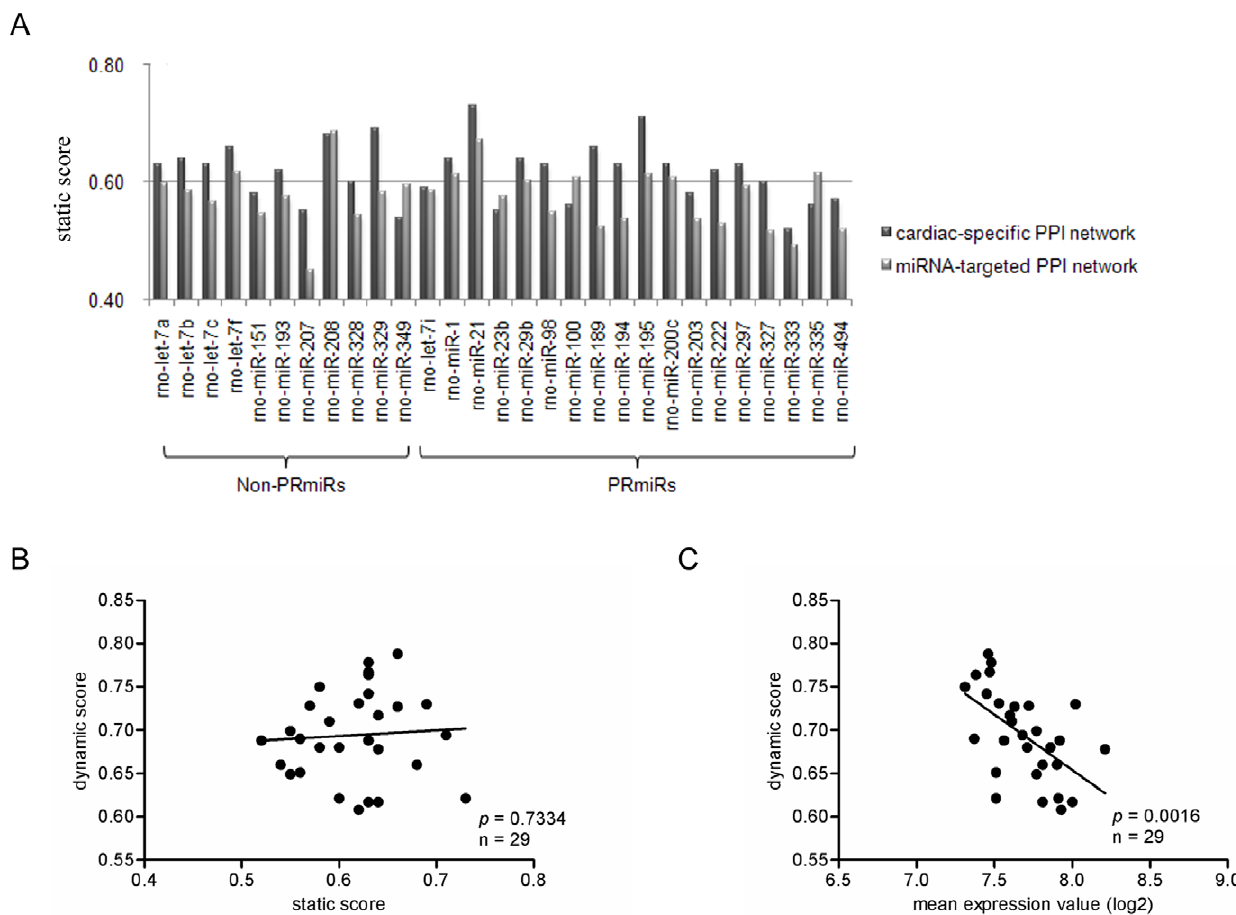
Figure 2. Results of static and dynamic network analyses. A. Static scores of the 29 dysregulated miRNAs in myocardial infarction. B. Correlation between static score and dynamic score. C. Correlation between average target gene abundance (log2) and dynamic score. non-PRmiR, dysregulated miRNA in myocardial infarction which expression could not be reversed by propranolol; PRmiR, propranolol-reversed miRNAs.